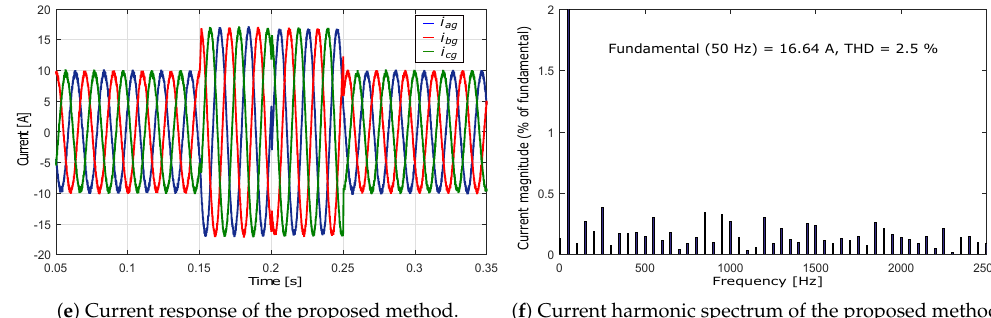
Figure 9. The dynamic response and harmonic spectrum of the grid current for DPC-SVM, conventional FCS-MPC, and the proposed